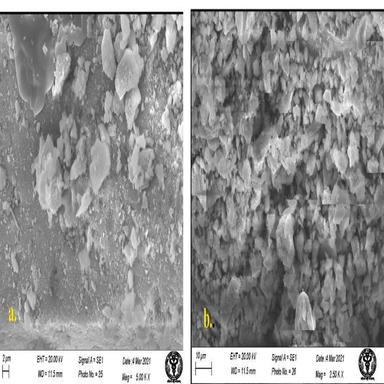
(a, b) SEM micrographs of MnFe2O4/OV,(c)EDAX spectrum of MnFe2O4/OV.